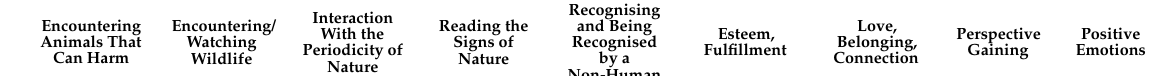
Table 3. Numbers of responses coded to all IP and PD